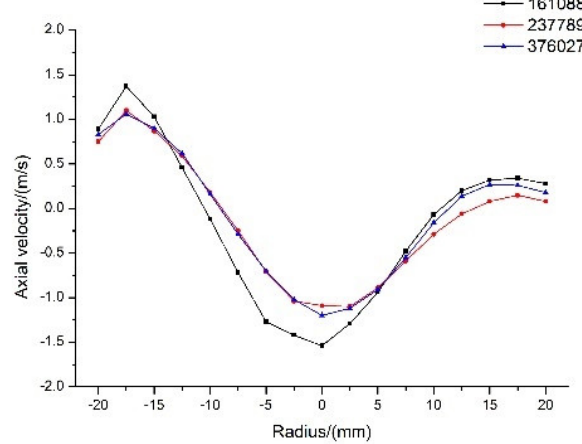
Figure 5. Mesh dependence